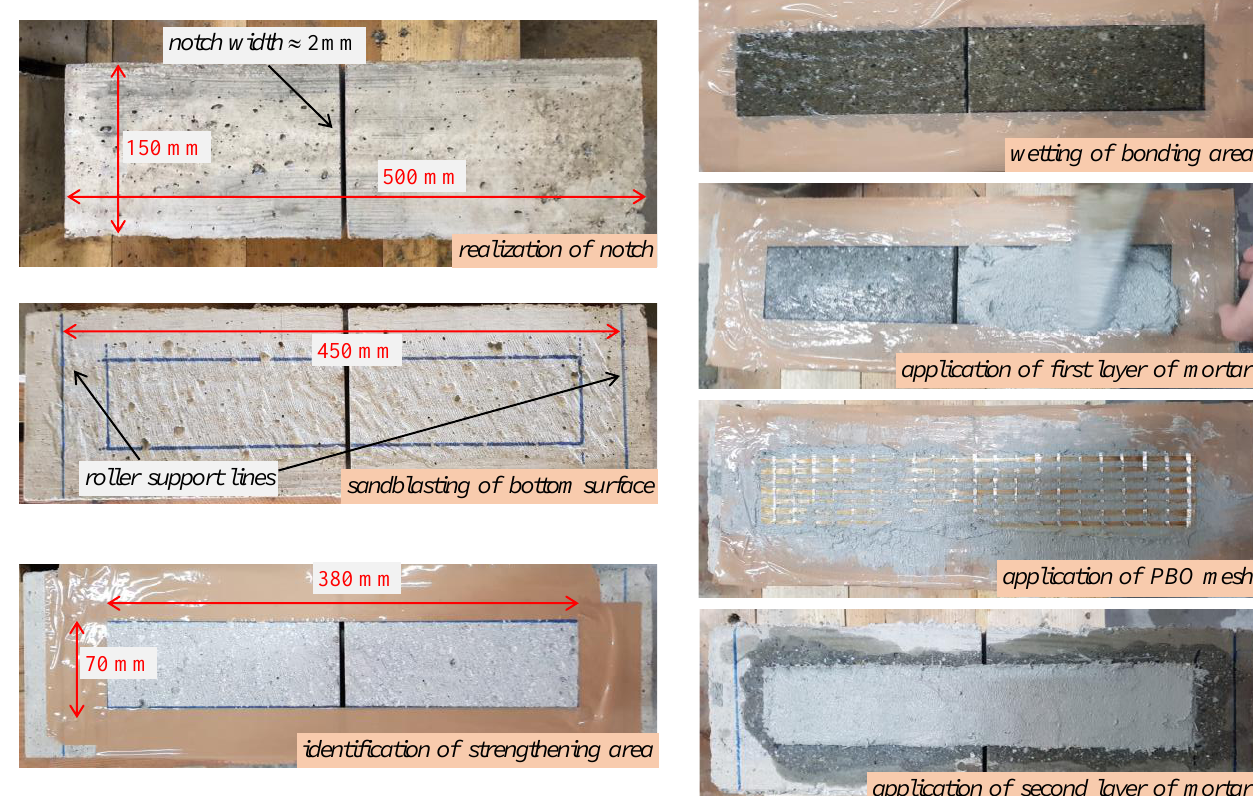
Figure 3. Notch realization and application of externally bonded PBO-FRCM sheet on the concrete beams.